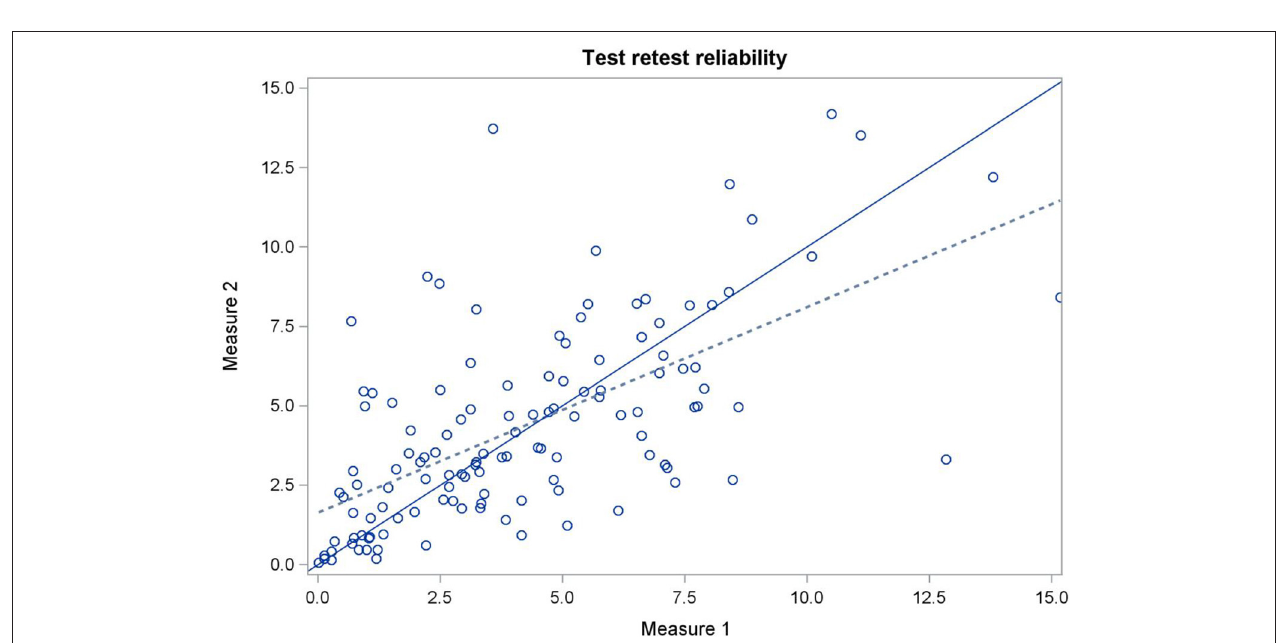
FIGURE 5 | Concordance correlation plot comparing test-retest reliability for mechanical nociceptive threshold quantified using an algometer. Data obtained using two consecutive measures per day for two raters and for five consecutive days on 36 milking cows. The full line represents the line of perfect concordance and dashed line represents reduced major axis. mean difference 0.92, 95% CI 0.06 to 1.78) but not for